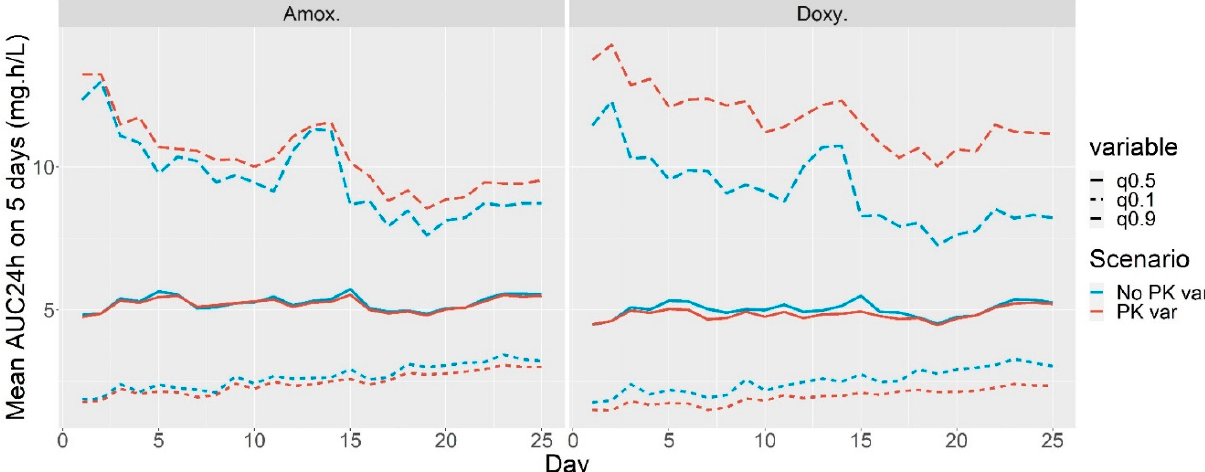
Figure 2. Median, 10% and 90% empirical quantiles of the AUC_24h distribution according to the day that the five-day treatment began, for amoxicillin (left) and doxycycline (right). The red curves correspond to simulations done with between-animal PK variability and the blue curves correspond to simulations done with the same PK parameters for all animals. The individual PK parameters variability has a very small influence on AUC_24h variability for amoxicillin. It has little impact on the 10% quantile of AUC_24h distribution for doxycycline and a larger impact on the 90%